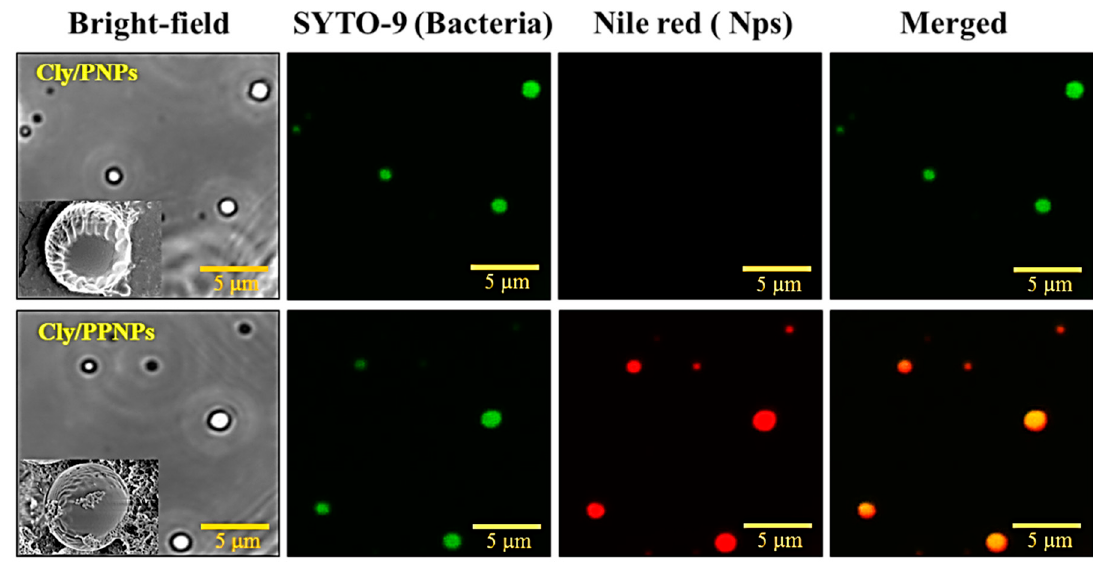
Figure 3. Adhesion of Cly/PNPs and Cly/PPNPs to bacteria. NPs were incubated with bacteria for 1 h and images were obtained using a confocal microscope. Bacterial membrane (green) is stained with Syto-9, and NPs (red) are labeled with Nile red. Inset images in figures show SEM images of NPs bound to bacteria.